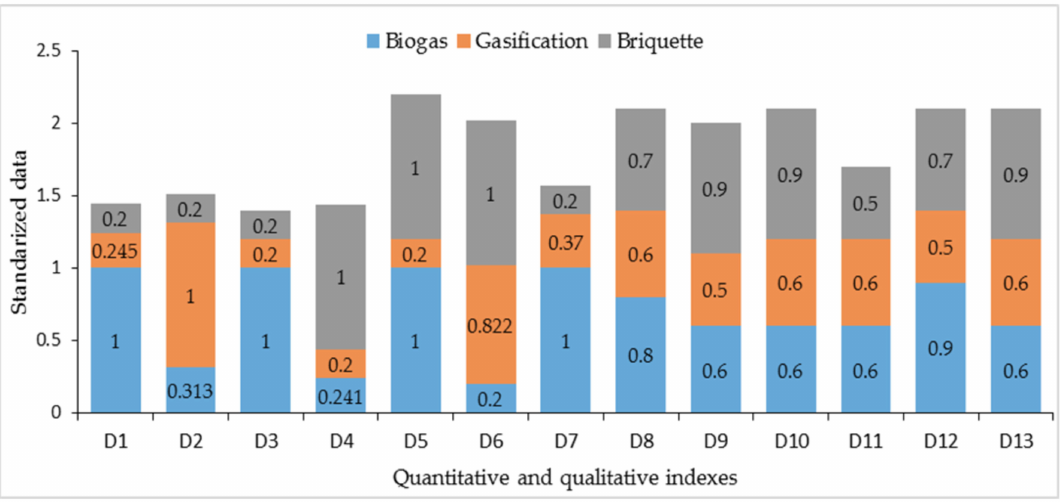
Figure 5. Dimensionless and normalized evaluation